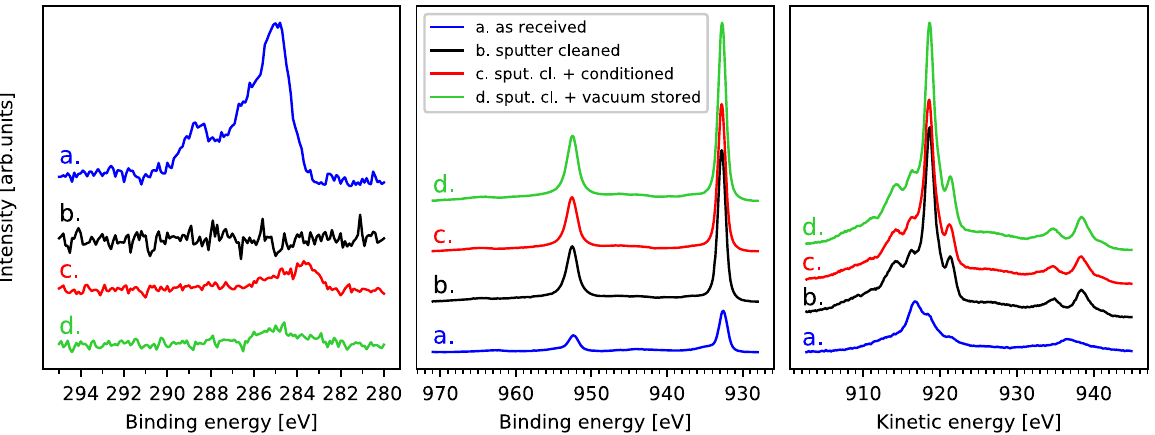
FIG. 4. C 1s (left), Cu 2p (center) and Cu LMM (right) lines of a sputter-cleaned sample, before and after conditioning, and of a sputter-cleaned sample stored under vacuum. The as received state of the sputter-cleaned sample is shown for comparison.